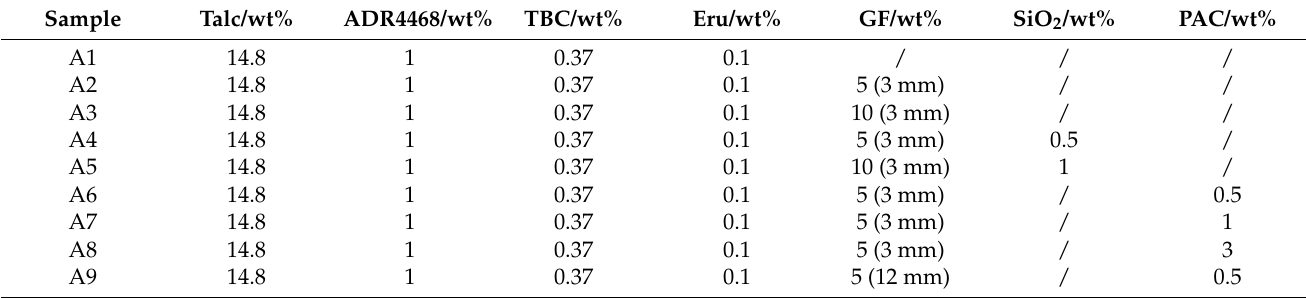
Table 1. Material